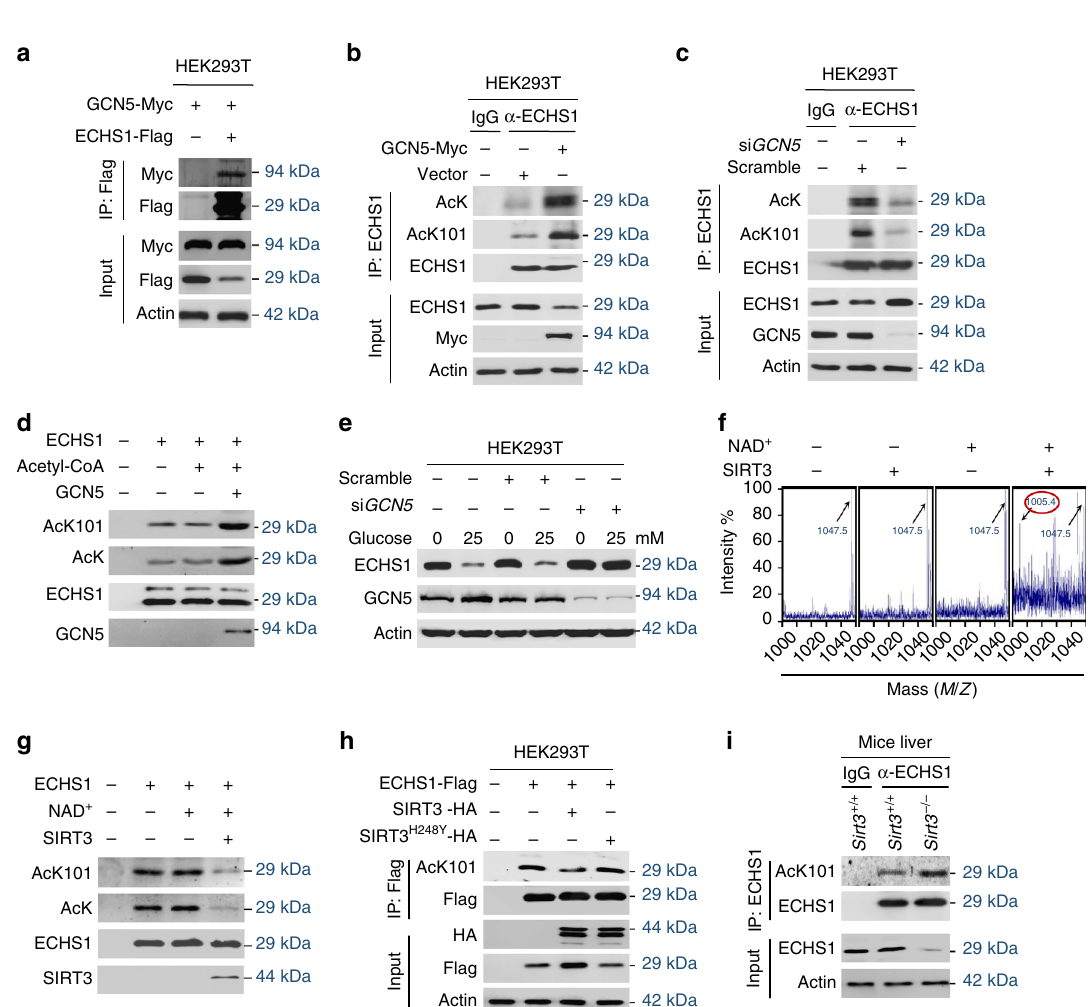
Fig. 3 GCN5 acetylates and SIRT3 deacetylates ECHS1. a Myc-tagged GCN5 and Flag-tagged ECHS1 were co-expressed in HEK293T cells. The co-puri fi ed Myc-tagged GCN5 was detected in Flag beads puri fi ed proteins. b , c Western blot detection of endogenous ECHS1, and AcK and AcK101 levels of af fi nity-puri fi ed ECHS1 from HEK293T cells and GCN5 overexpressing HEK293T cells ( b ) and from HEK293T cells and GCN5 knockdown HEK293T cells ( c ). d Western blot detection of AcK and AcK101 levels of recombinant ECHS1 that before and after in vitro acetylation by GCN5. e The levels of endogenous ECHS1 were detected in HEK293T and GCN5 knockdown HEK293T cells that were cultured in the absence of glucose or presence of glucose. f The synthetic acetylated K101-containing ECHS1 peptide was deacetylated by recombinant SIRT3. The synthetic peptide (1047.5) and de-acetylated products (1005.4, red-circled ) were assayed by MS. g The levels of AcK and AcK101 of hyperacetylated ECHS1 (from NAM treated cells) were detected before and after in vitro treatment by SIRT3. h ECHS1 was co-expressed with SIRT3 or SIRT3 H248Y in HEK293T cells. The AcK101 levels of puri fi ed ECHS1 were determined. i The Ac101 levels of af fi nity-puri fi ed ECHS1 from liver of Sirt3 KO and control